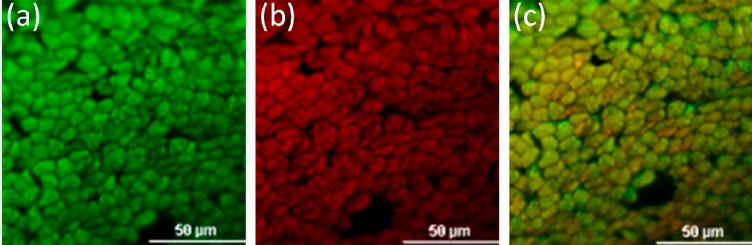
Figure 8. The distribution of accelerant and D5 in PET fiber cross-sections: ( a ) FITC channel in D5, ( b ) G-2A channel in accelerant, and ( c ) merged channel.